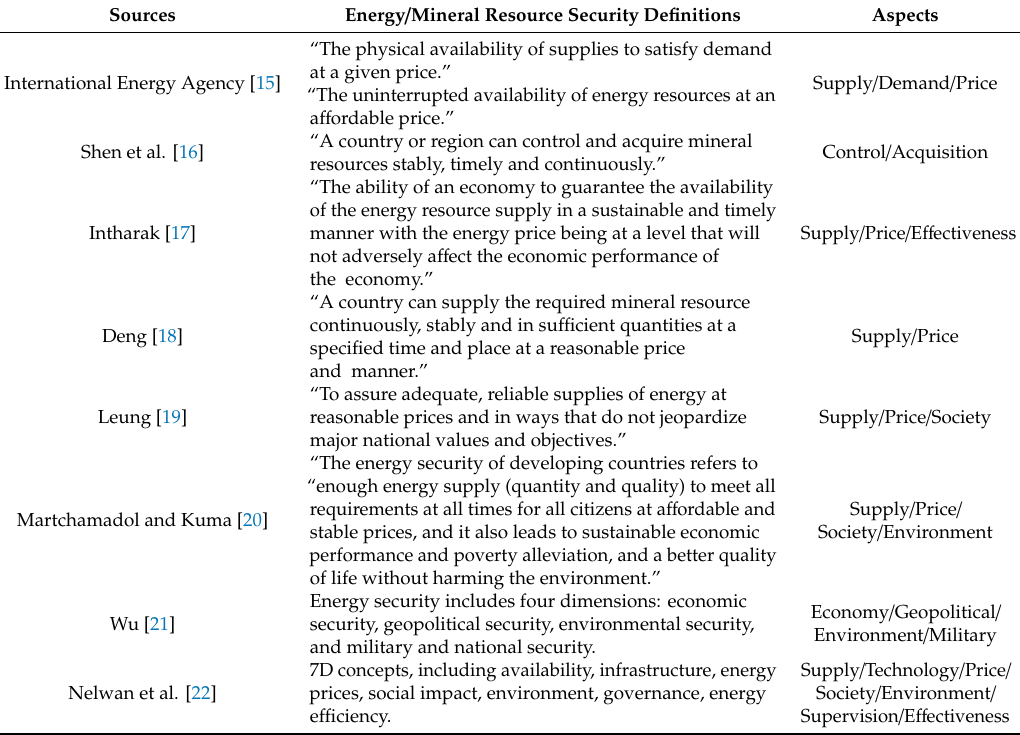
Table 1. Representative definitions for energy / mineral resource